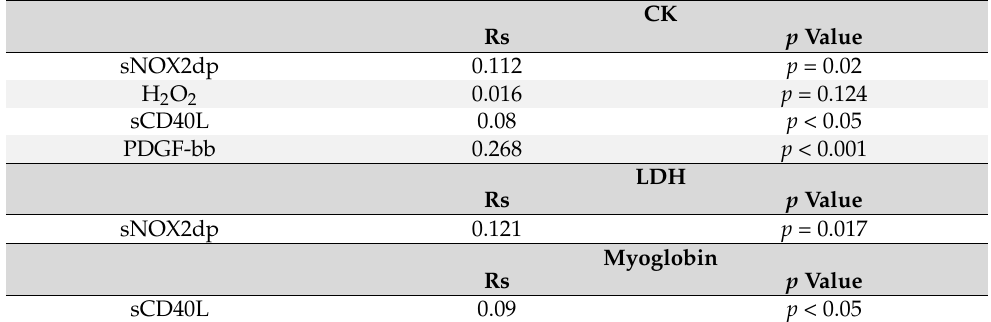
Table 2. Correlation between biomarkers of muscle injury and oxidative stress and platelet activation.